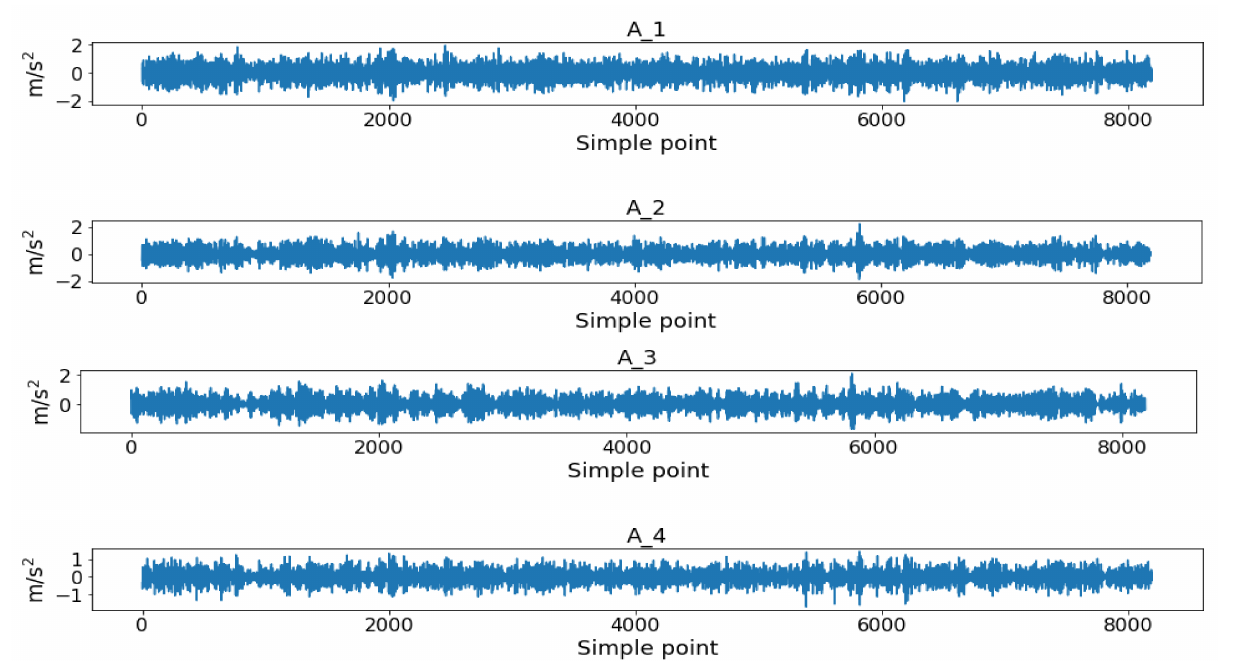
Figure 7. Acceleration data set collected from the three-story structure.